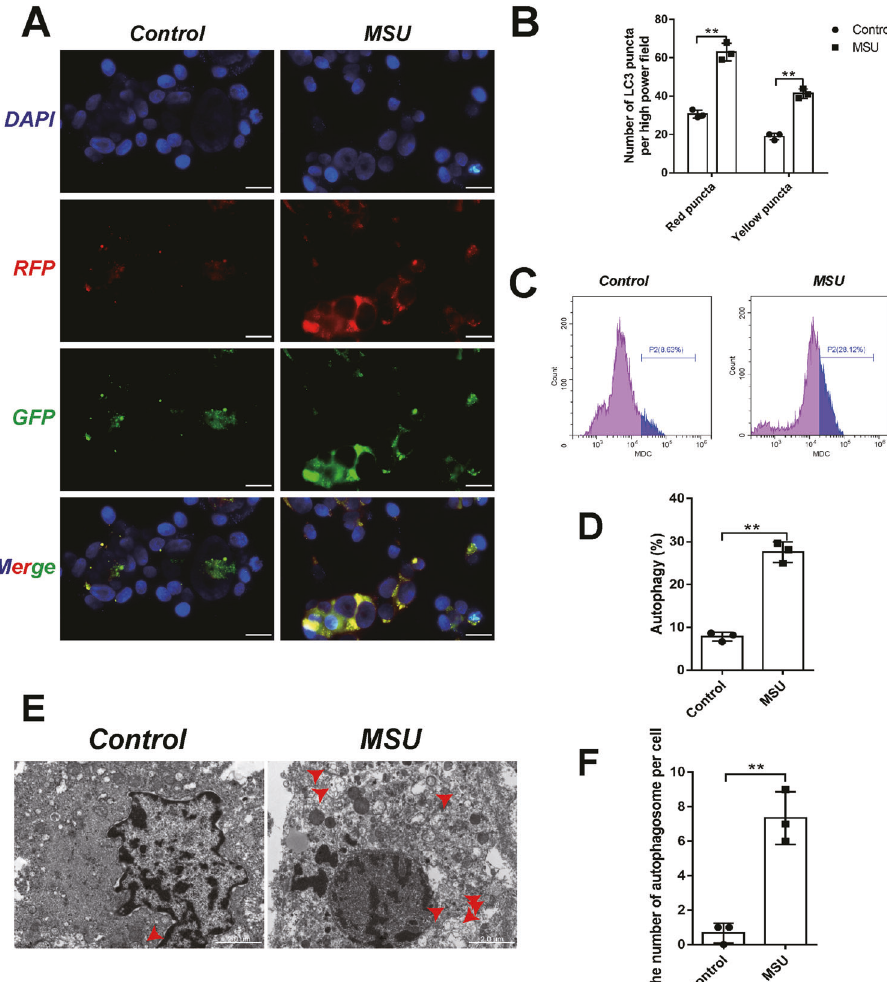
Fig. 2 MSU-induced autophagy of C28/I2 cells. C28/I2 cells were incubated with MSU (200 μ g/mL) for 24 h. Transfection of the mRFP-GFP- LC3 ( A , B ) plasmid into C28/I2 cells and quanti fi cation of the autophagic puncta by confocal microscopy, bar = 20 μ m. To evaluate autophagic vacuoles, C28/I2 cells were stained with MDC, and the autophagy ratio of C28/I2 cells in the indicated groups was measured by fl ow cytometry ( C , D ). The morphology ( E ) and the number ( F ) of autophagosome in C28/I2 cells were observed by transmission electron microscope, bar = 2 μ m. The red arrow points to the autophagosome. Results are the mean ± SD for three individual experiments. * P < 0.05, ** P <